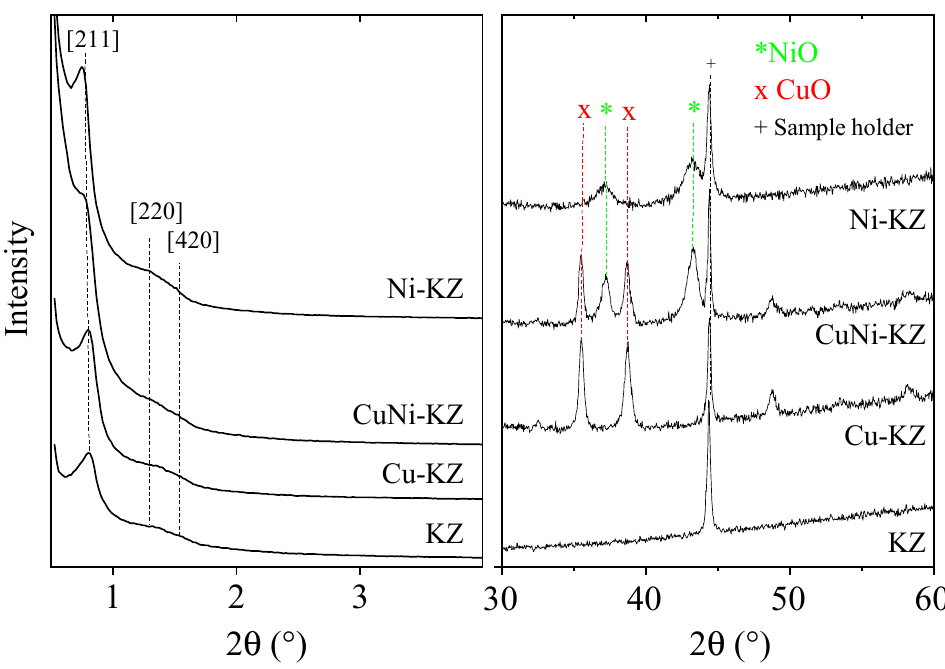
Figure 1. X-ray powder diffraction patterns of the parent and transition metal-modified KIT-6 based composites at low and at wide angles.